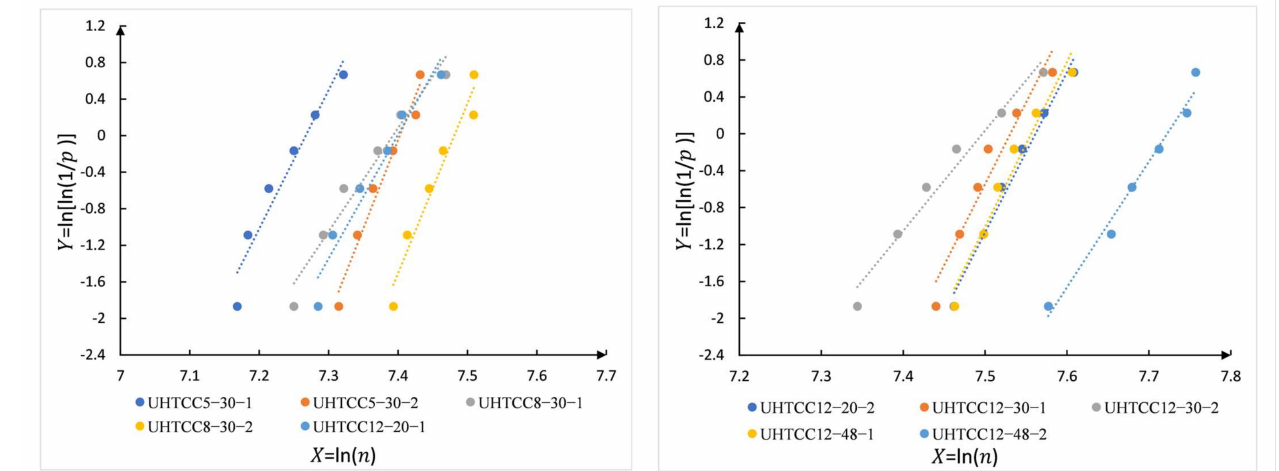
Figure 9. UHTCC Weibull Model Linear Regression